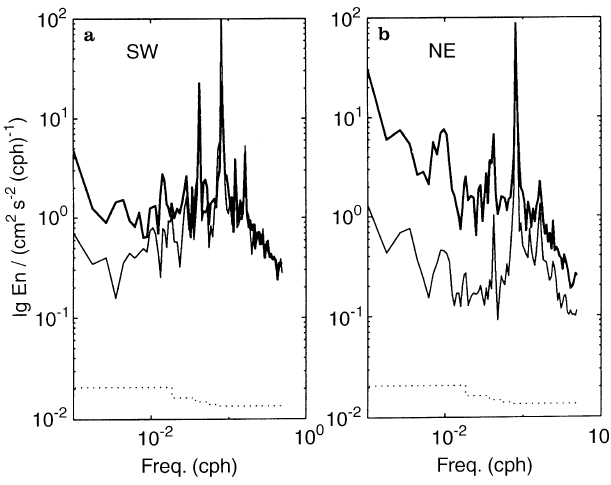
Fig. 7a, b. Variance preserving power spectra for a SW and b NE current meter. Thick lines are the along-slope velocity component and thin the across-slope velocity. The 90% upper confidence limit is shown by the dotted